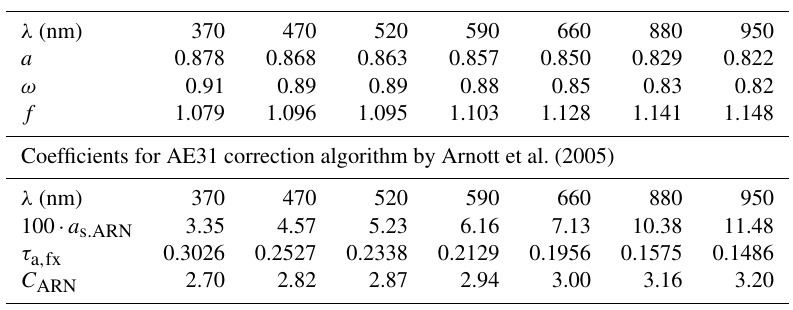
Table 1. All the wavelength-dependent coefficients used in the AE31 correction algorithms proposed by Weingartner et al. (2003) and Arnott et al. (2005). The extrapolated values of the multiple-scattering correction factor used in the Arnott et al. (2005) correction algorithm ( C ARN ) at different wavelengths. Coefficients for AE31 correction algorithm by Weingartner et al.